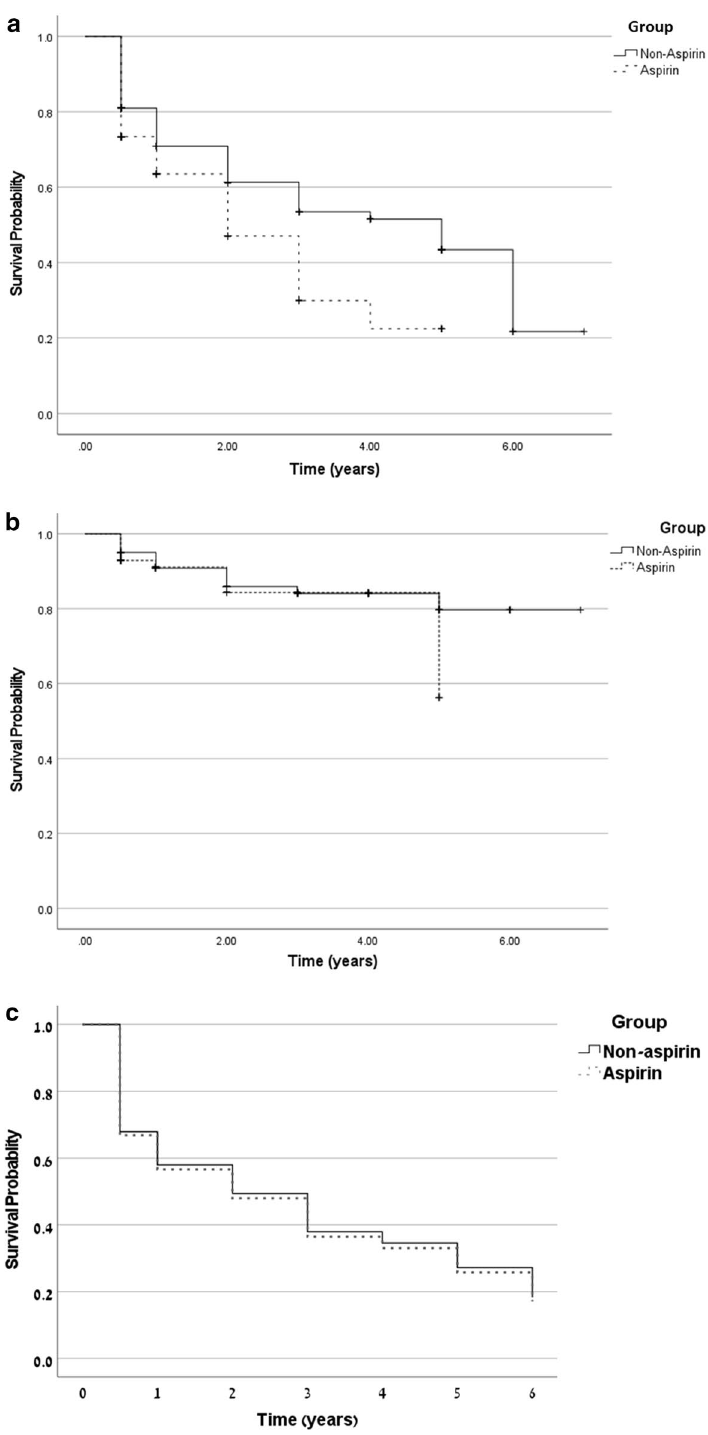
Figure 3. Cox proportional hazard regression models in aspirin versus non-aspirin users An adjusted Cox proportional hazard regression model was done after controlling diabetes, atrial fibrillation, age group and CKD group. ( a ) Cox regression survival curve for CVD. ( b ) Cox regression survival curve for bleeding. ( c ) Cox regression survival curve for all-cause